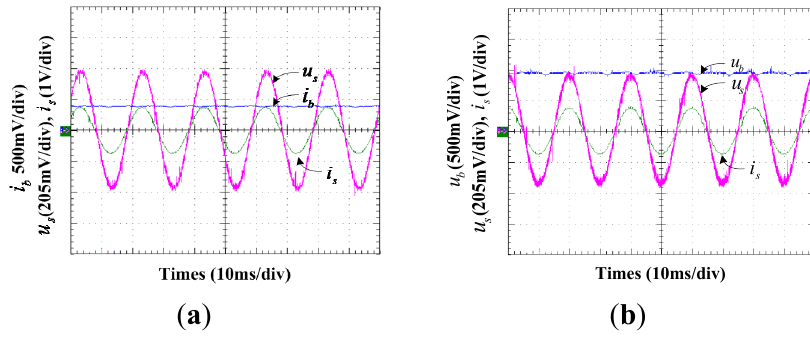
Figure 15. The voltage and current in charging mode. ( a ) Constant current charging mode; ( b ) Constant voltage charging